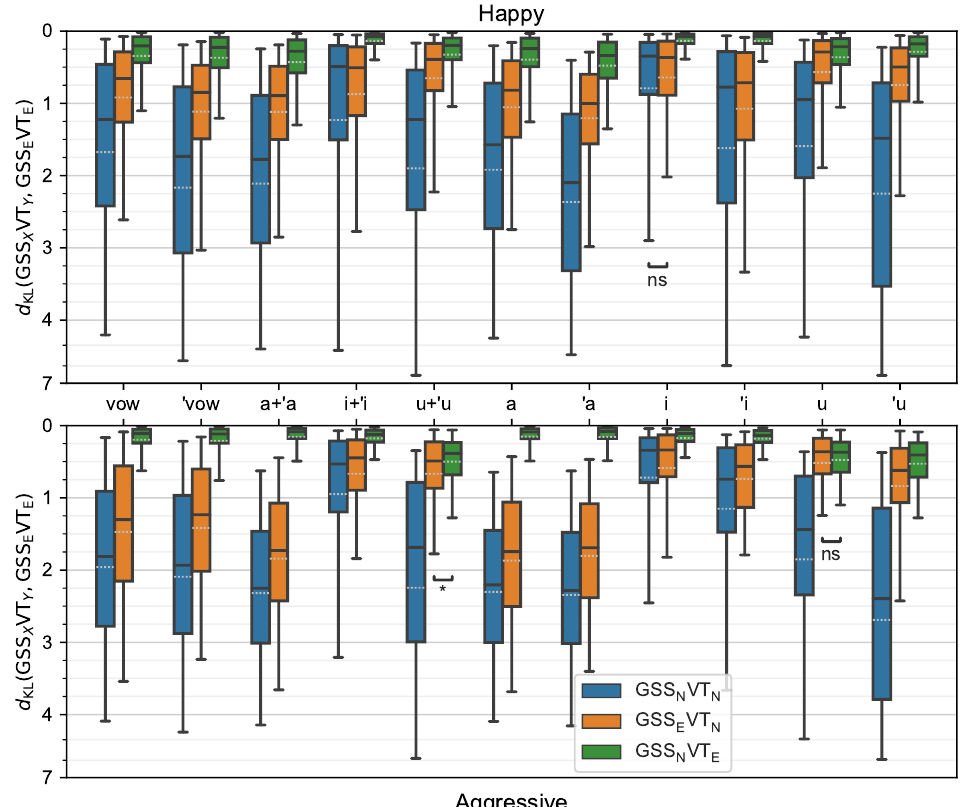
Figure 4. Boxplots of the Kullback–Leibler distances from the analysed configurations to the target configuration (GSS E VT E ) for happy and aggressive vowels. Dotted lines represent the mean of the distributions, and whiskers are set to the 5th and 95th percentiles. The differences between configurations are statistically significant ( p < 0.01) except those marked with * ( p < 0.05) and ns (no